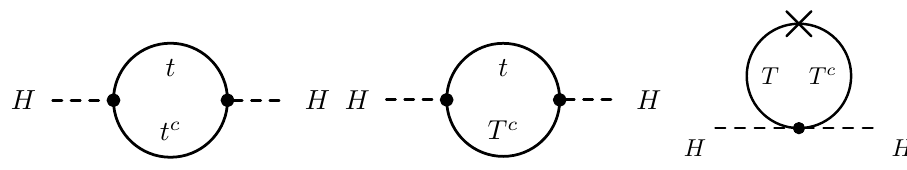
Figure 2 . Diagrams involved in the cancellation of top loop in a spin 1/2 top partner model. The original one-loop diagram of SM top (left), the one-loop diagram with HTt c interaction (middle), and the one-loop diagram with a dimension-(cid:12)ve h 2 TT c coupling and a T mass insertion